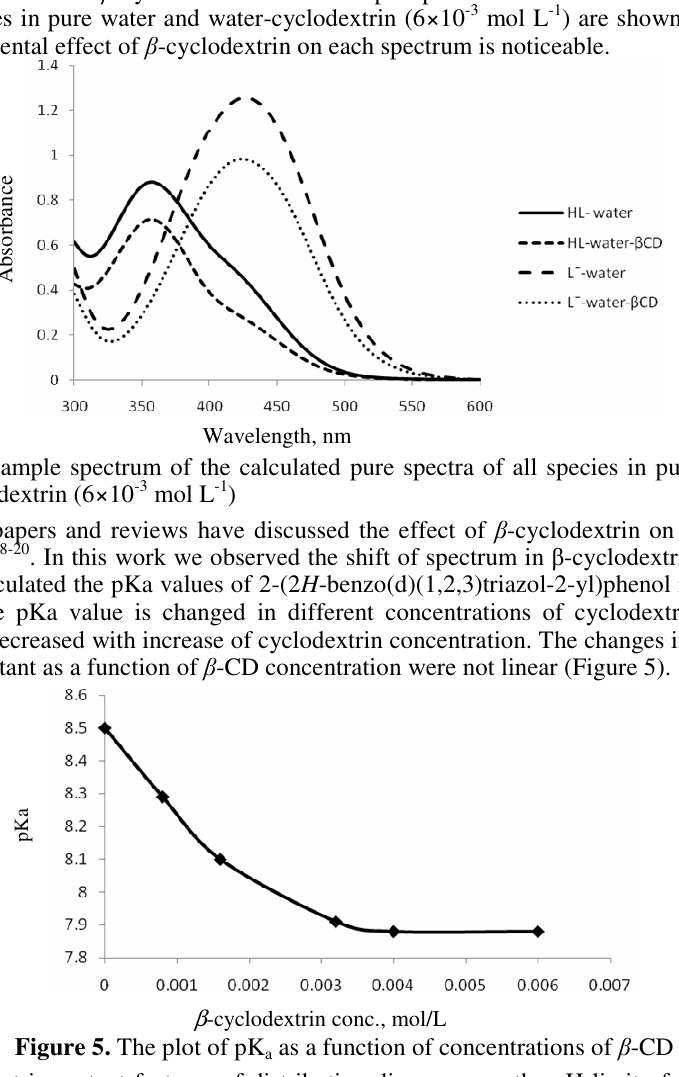
as a function of concentrations of β a